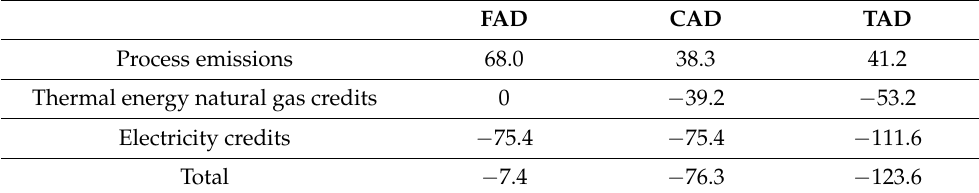
Figure 7. Process contribution analysis of the total CO 2 eq emissions. Table 4. GHG emissions of the three systems (t of CO 2 equivalent in 20 years).